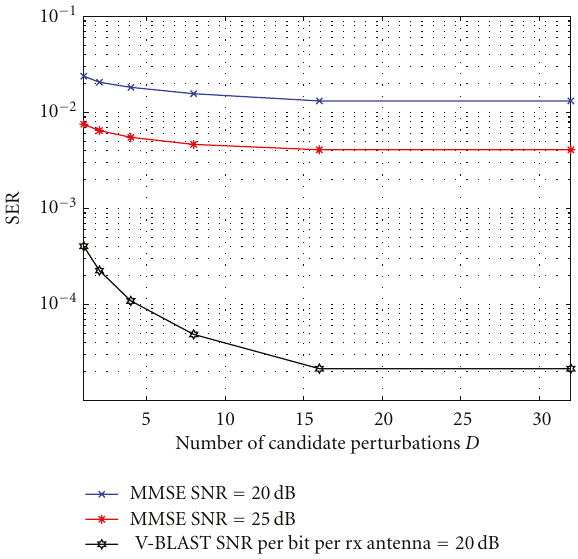
Figure 5: SER versus SNR for MMSE, MMSE-SA for increasing D , N = M = 5, N t = 1, QPSK.